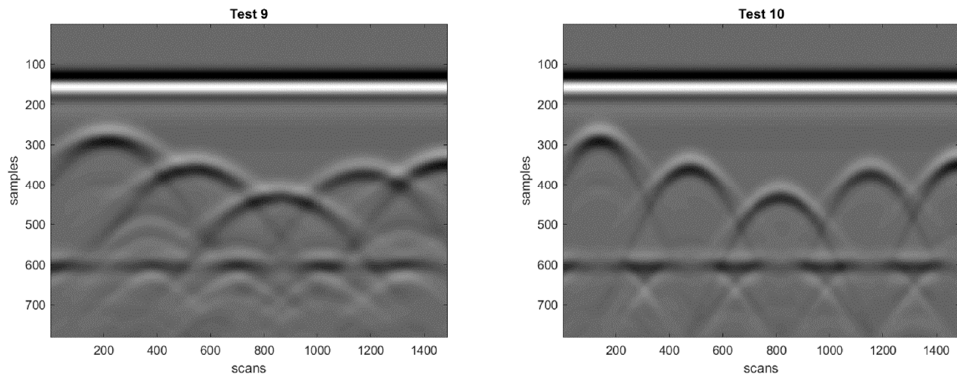
Figure 6. Synthetic radargrams generated using the electromagnetic simulator gprMax.